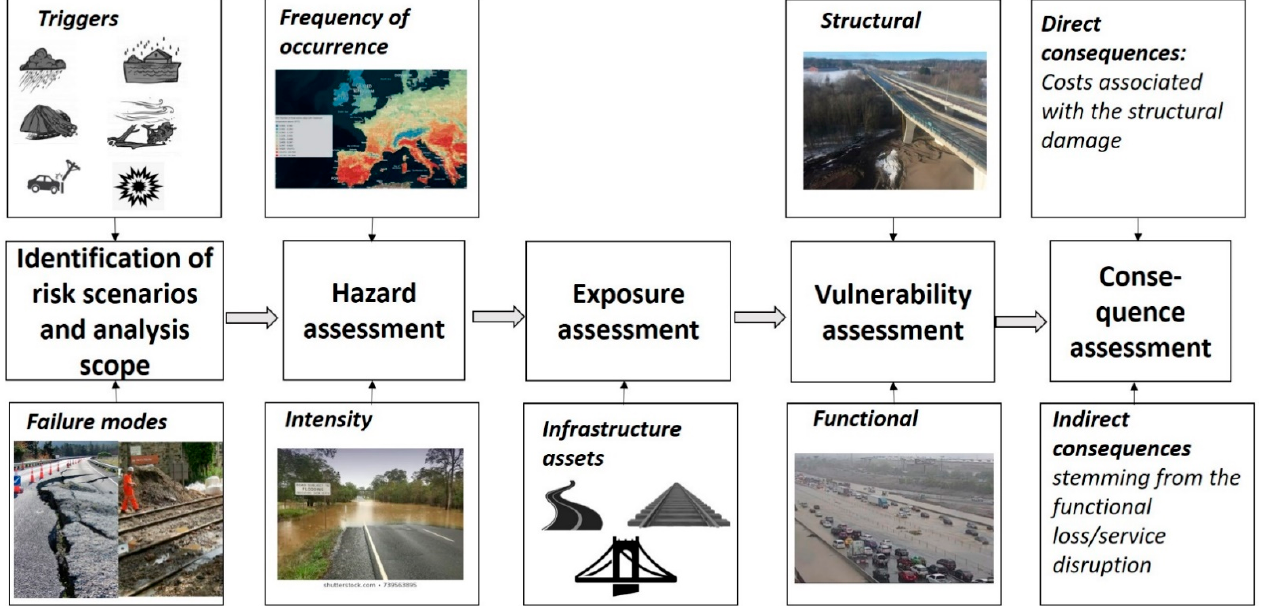
Figure 2. Framework for assessment of risk associated with extreme events on transportation systems.